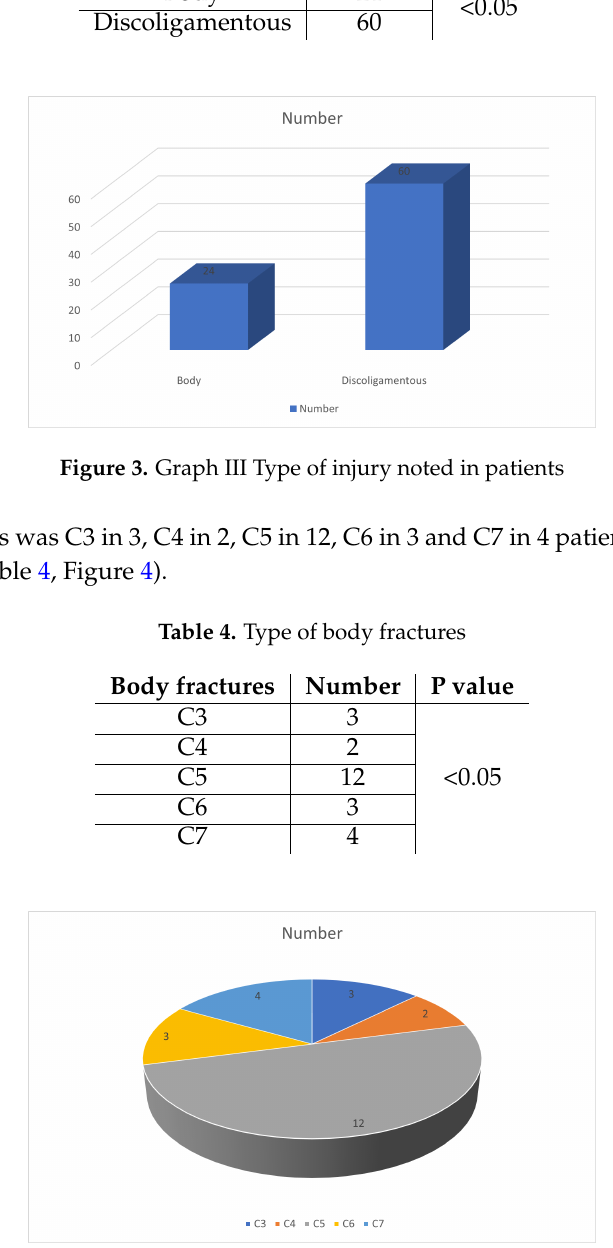
Figure 4. Graph IV Type of body fractures